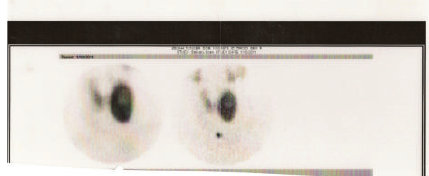
Figure 1: Thyroid scan reveals the active nodule of the left lobe and suppression in the remaining thyroid tissue.